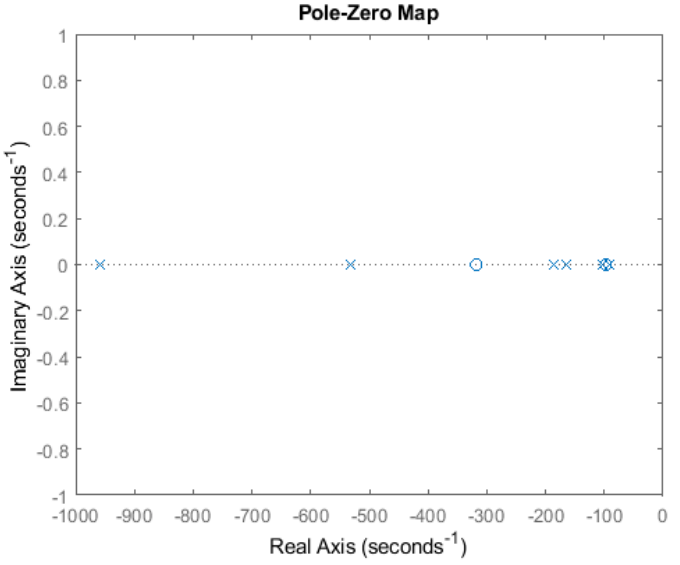
Figure 8. Argand diagram of the closed-loop AMB system, X and O are system poles and zeros, respectively. Table 1. AMB system parameters.